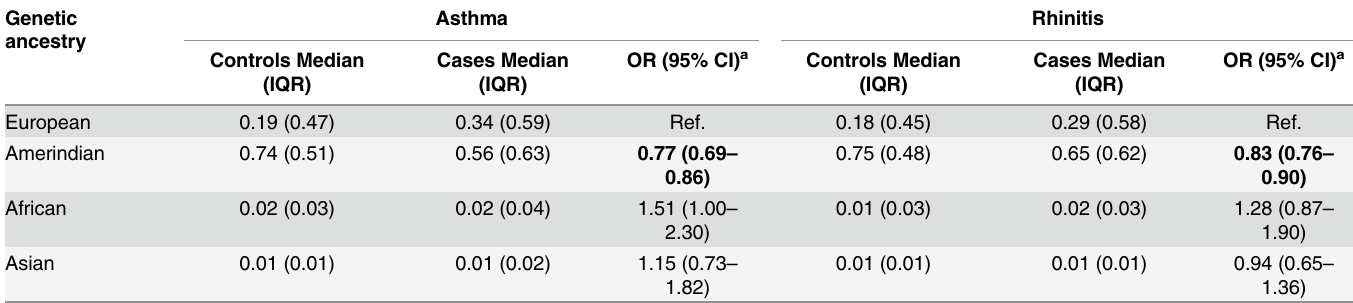
Table 3. Distributions of Genetic Ancestry and Univariate relationship between Genetic Ancestry and Asthma and Rhinitis. Genetic